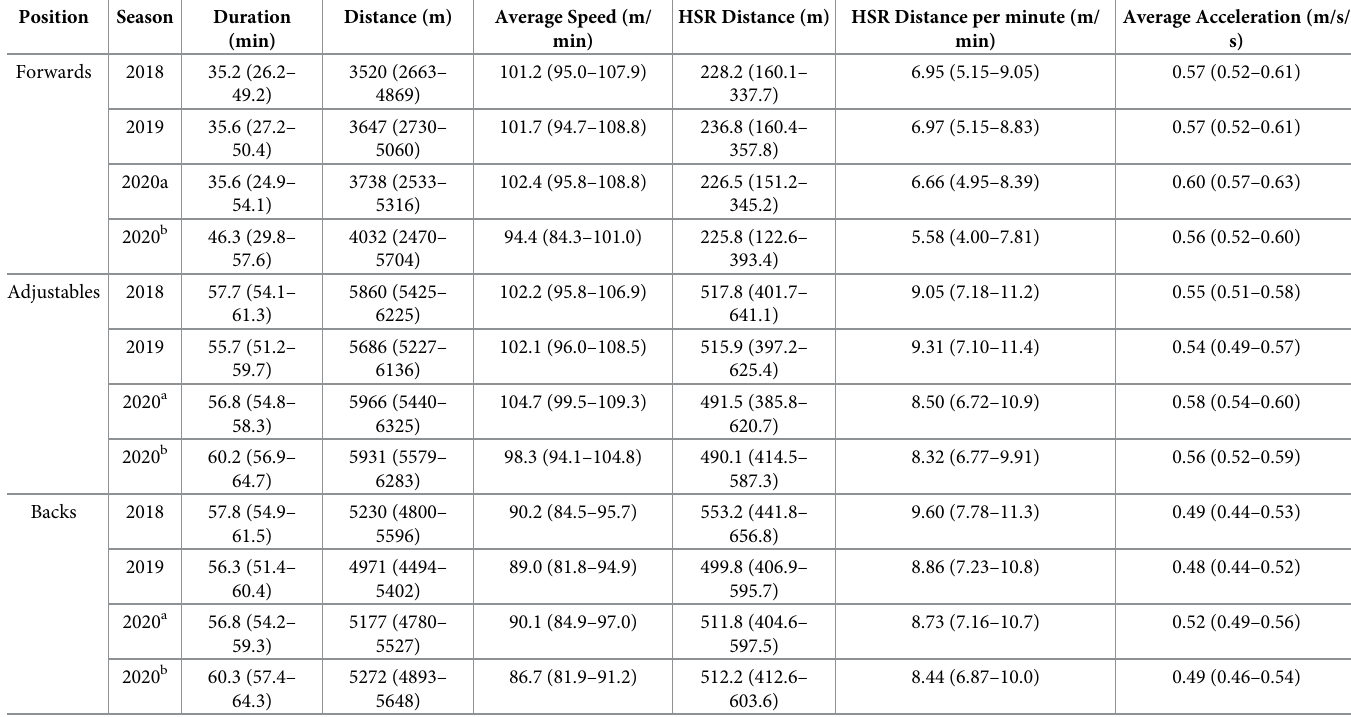
Table 2. Ball-in-play physical characteristics stratified per positional category between seasons (Median [interquartile range]). Position